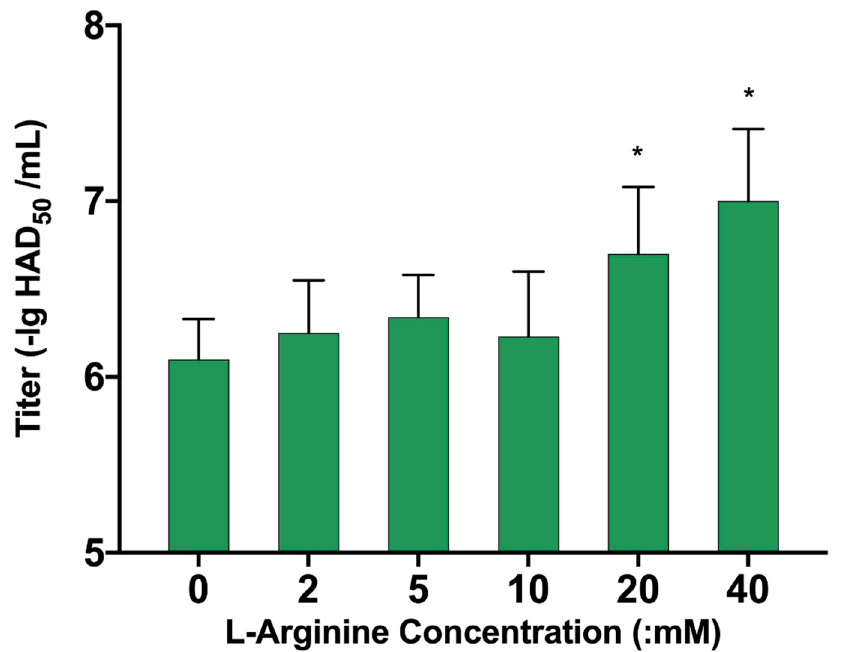
Figure 9. The influence of different concentrations of L-Arginine on ASFV replication. PAM cells were pretreated with 2, 5, 10, 20, and 40 mM L-Arginine for 24 h, then PAM cells were infected with ASFV, cell culture supernatant was harvested 72 h post-infection, and the titer of ASFV virus was detected by the HAD 50 method. The p values were calculated, * p < 0.05.